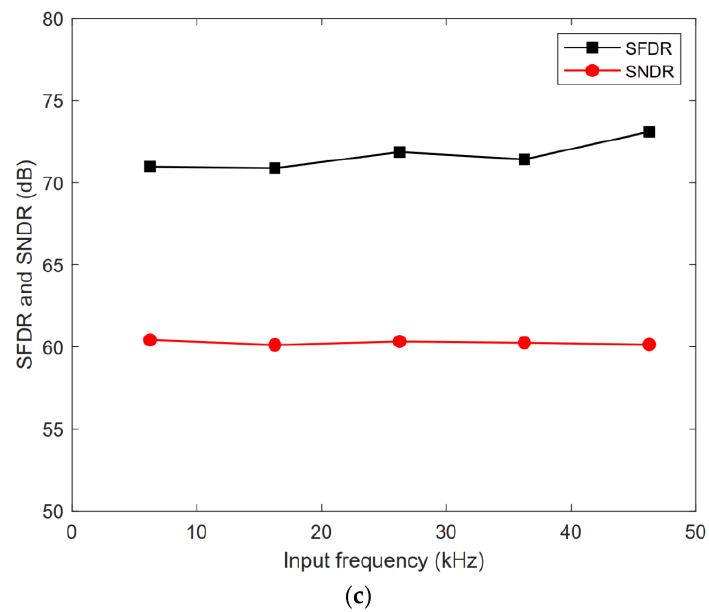
Figure 18. SNDR/SFDR with various input frequencies: ( a ) 8-bit mode; ( b ) 9-bit mode; ( c ) 10-bit mode.